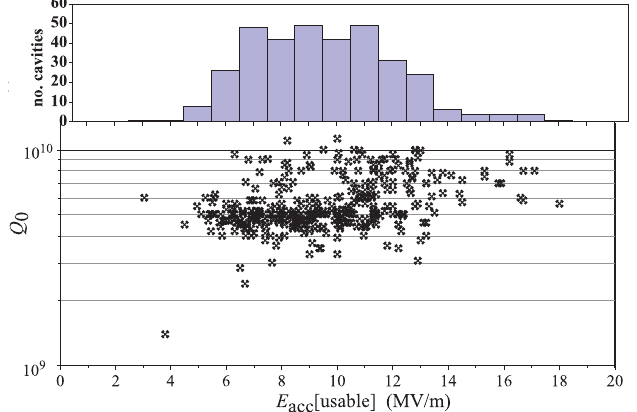
FIG. 6. CEBAF cavity usable performance per vertical accep- tance tests (from [51]).